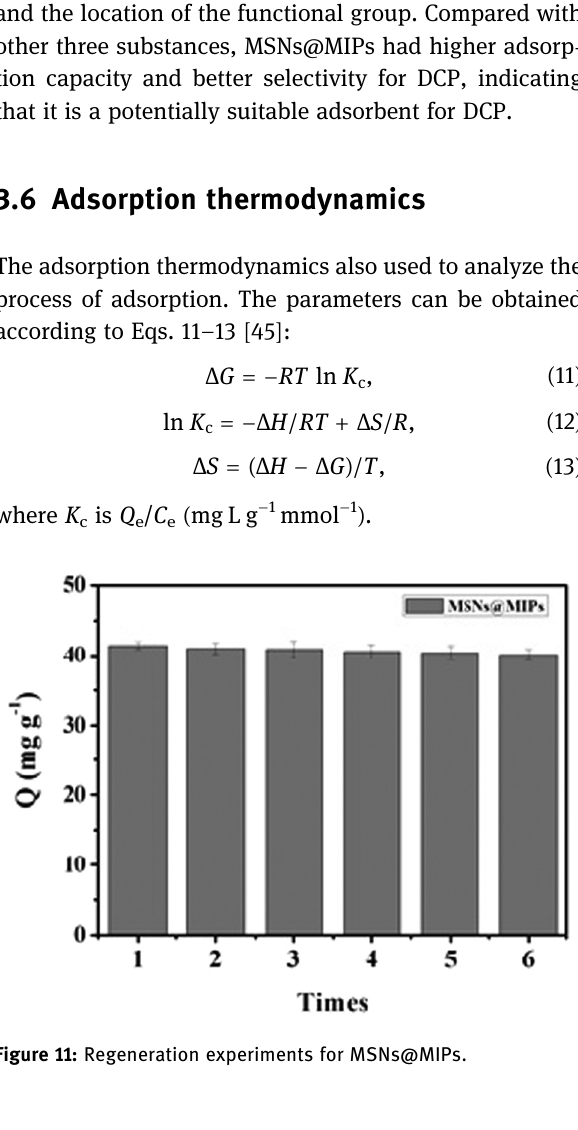
Table 6: Recoveries and RSD of DCP in river water using MSNs@MIPs and MSNs@NIPs Samples Added ( mg/L )